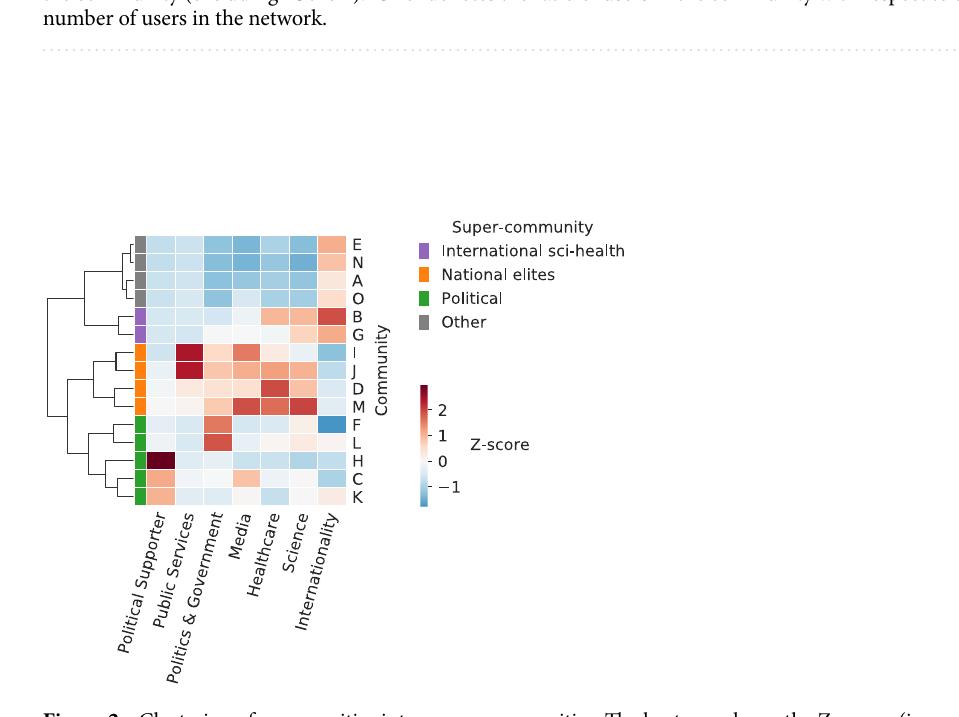
Figure 2. Clustering of communities into super-communities. The heatmap shows the Z-scores (i.e. standardized values) for seven chosen features. The four super-communities denote the emerging